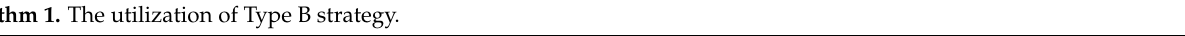
Algorithm 1. The utilization of Type B strategy.